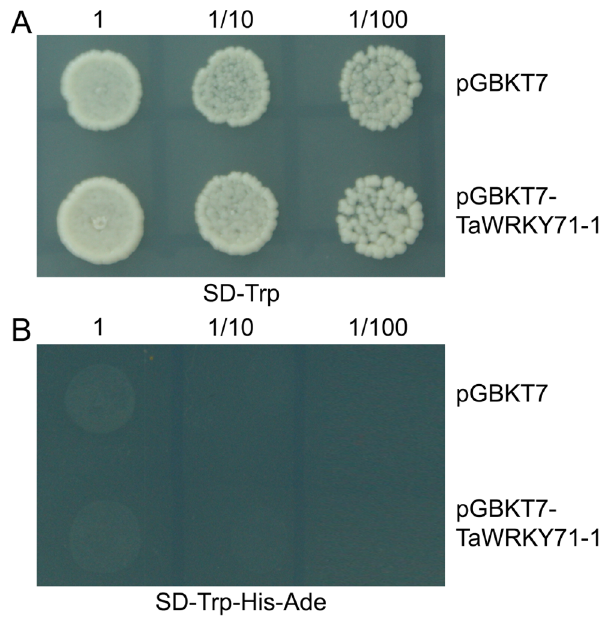
Figure 4. TaWRKY71-1 has no transactivation activity. The full length ORF of Ta WRKY71-1 was constructed into pGBKT7, and transformed yeasts were selected on both SD-Trp and SD-Trp-His-Ade media,